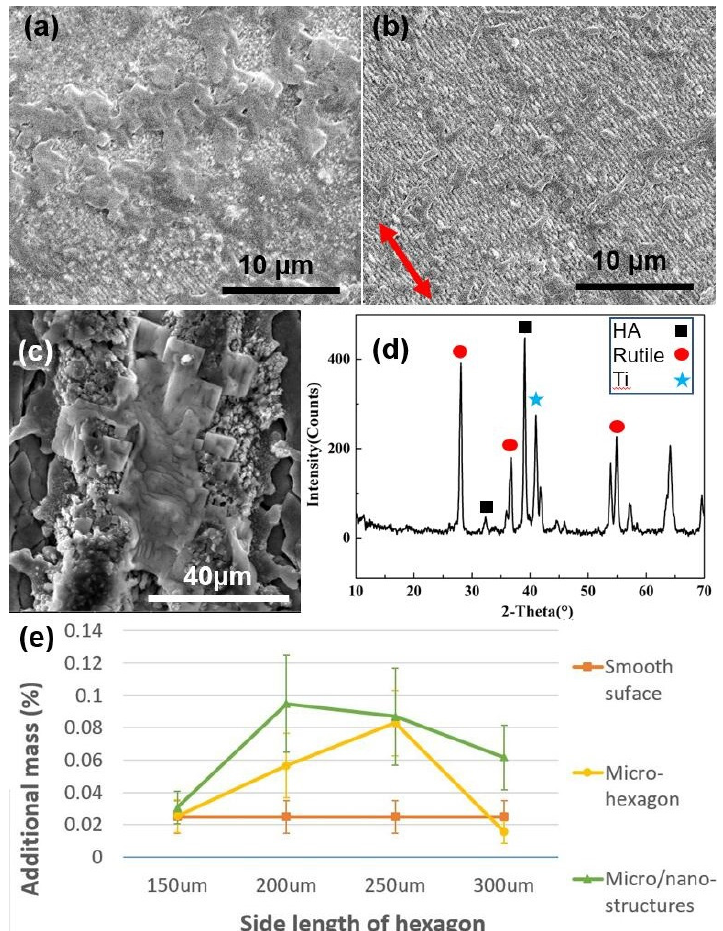
Figure 4. ( a ) SEM image of Ca–P surface morphology on the nano-ripples within the micro-hexagon at a hexagon side length of 200 µ m after being immersed in SBF for 15 days. ( b ) SEM image of a small amount of Ca–P crystals on the nano-ripples within the micro-hexagon (the arrow indicates the orientation of nano-ripples). ( c ) SEM image of Ca–P surface morphology in the channel between micro-hexagons. ( d ) XRD spectrum of deposited Ca–P on Ti-6Al-4V samples with bioinspired micro / nano-structures. ( e ) Additional mass of deposited Ca–P on Ti-6Al-4V samples with smooth surface, micro-hexagons and micro / nano-structures at di ff erent side length of the hexagon: 150 µ m, 200 µ m, 250 µ m and 300 µ m, respectively, after being immersed in SBF for 15